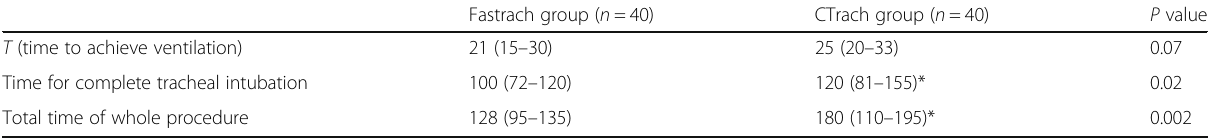
Table 3 Times for tracheal intubation and ventilation recorded in seconds